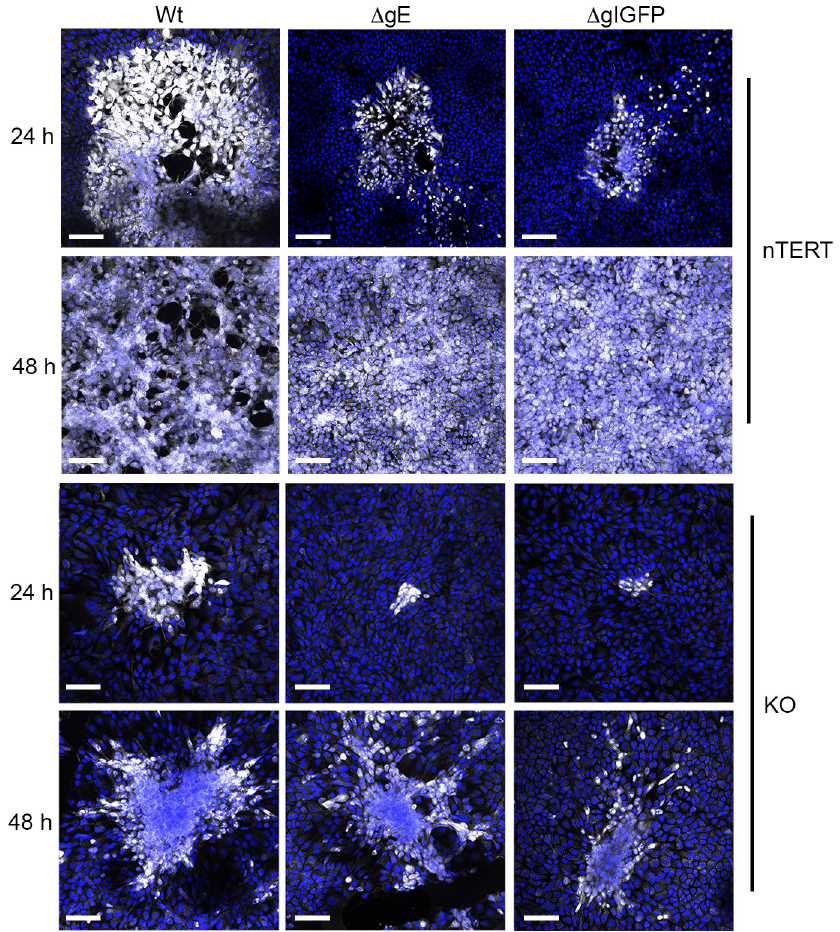
Fig 9. Relative spread of viruses in nectin1 KO cells. nTERT and KO cells grown on coverslips were infected with 50 or 2000 plaque forming units respectively of HSV1 Wt (Sc16), Δ gE or Δ gIGFP, fixed at 24 h or 48 h and stained for ICP4 (white). Nuclei were stained with DAPI (blue). Scale bar = 100 μ